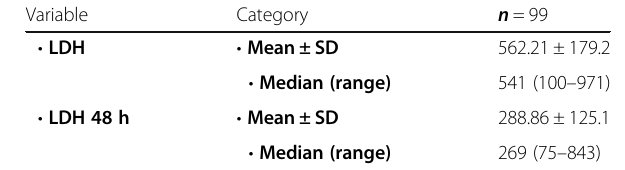
Table 3 LDH findings of the studied sample Variable